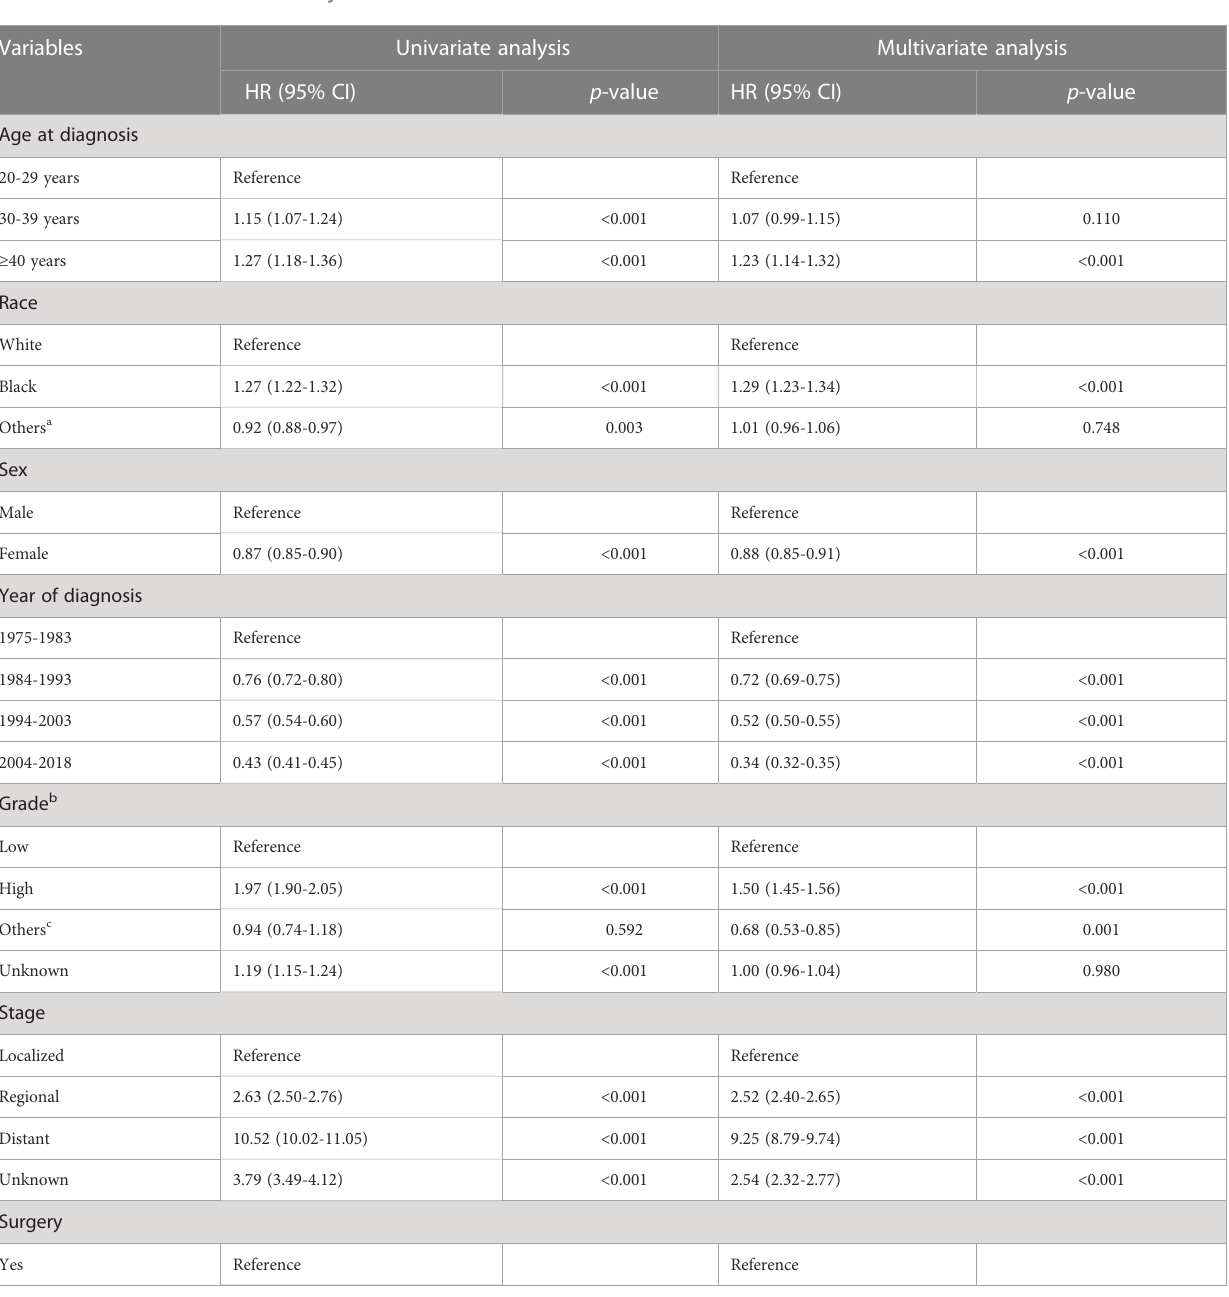
TABLE 3 Univariate and multivariate analyses of overall